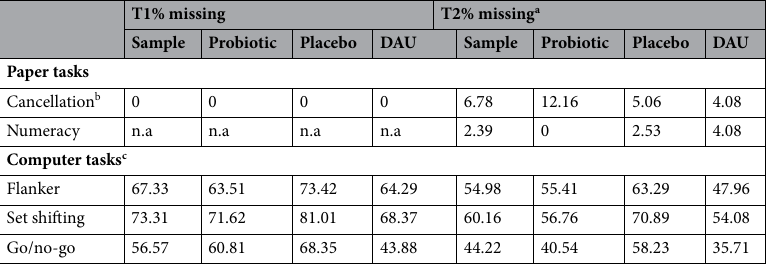
Table 2. Percentages of missing data by task. DAU Diet as usual, n.a. not administered. a 6 lost to follow-up; b 11 lost due to procedure change; c primary reason for missing response is failure to pass practice rounds of test (< 0.5% of responses lost due to computer